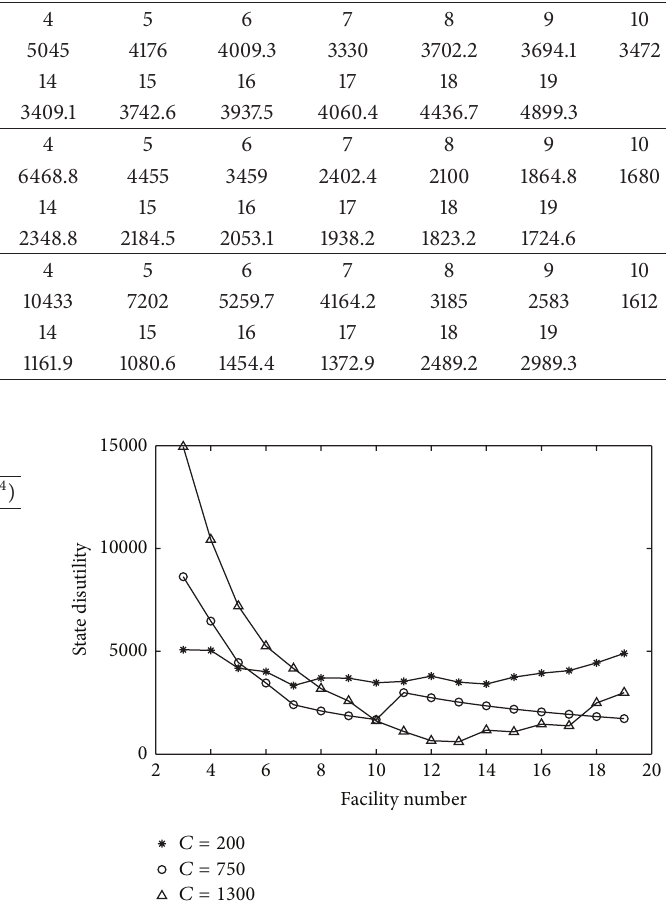
Figure 2: The relationship between facility number and the state